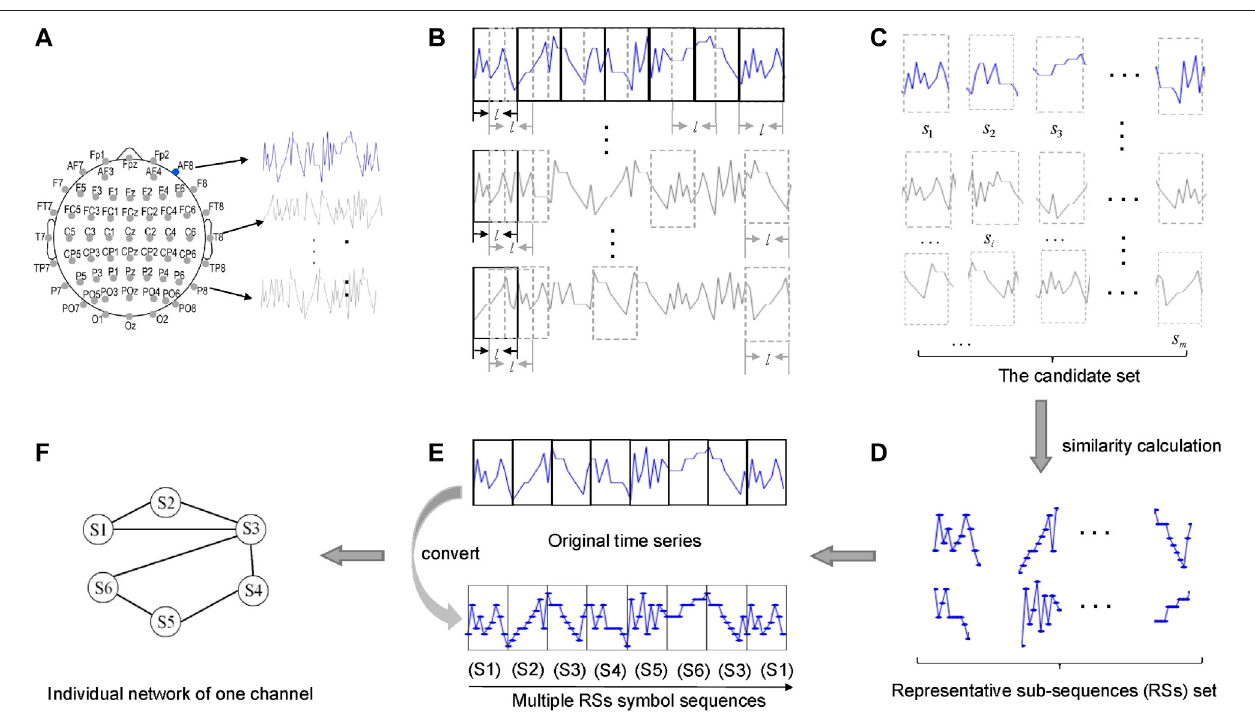
FIGURE1| Constructionofanindividualnetworklayerforeach channel. (A) EEGchannellocationsanditsrecordedtimeseries. (B) Segmentation processoftime series. (C) Candidate set of sub-sequences. (D) The representative sub-sequences (RSs) set. (E) The process of replacement. (F) The individual network (layer) for one